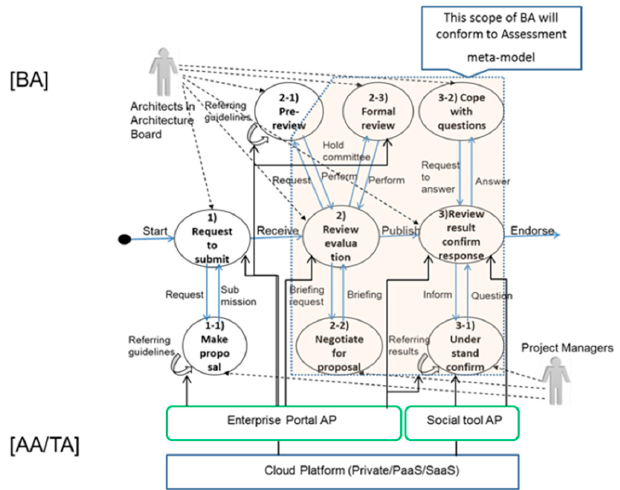
Figure 6. Social collaboration model (SCM) for architecture review in Architecture Board [5,38].